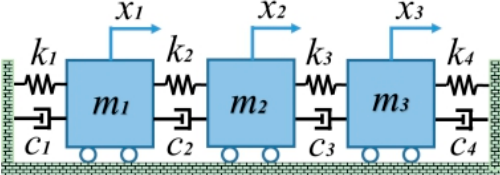
Figure 5. Three-degree-of-freedom (DOF) system consisting of spring and damper.